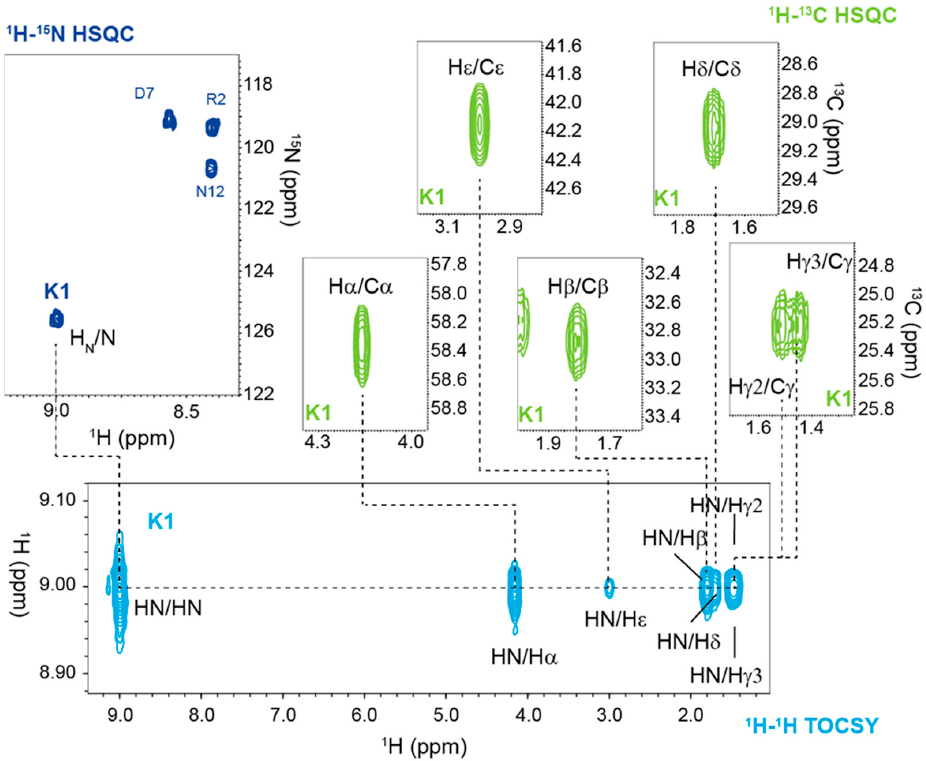
Figure 2. Chemical shifts assignment strategy. Illustration of the procedure used to assign 1H, 13C, and 15N chemical shifts for RGDechi1-14 and ψ RGDechi by exploiting the natural isotopic abun- dance. For example, 2D heteronuclear (1H-15N HSQC and 1H-13C CT HSQC) and homonuclear 1H-1H TOCSY NMR spectra analyzed to assign Lys1 resonances of RGDechi1-14. Data acquisition was performed for RGDechi1-14 and ψ RGDechi peptides at 298 K on 600 MHz